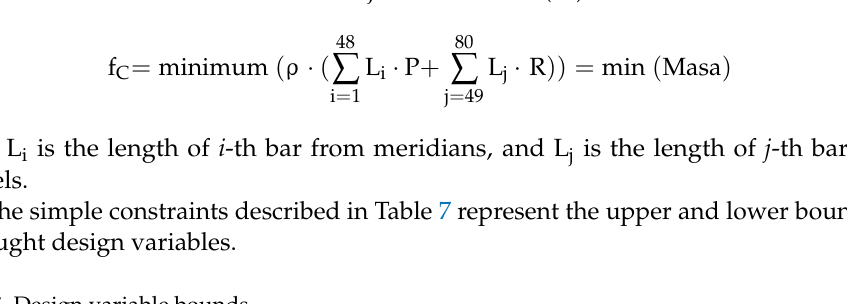
Table 7. Design variable bounds.